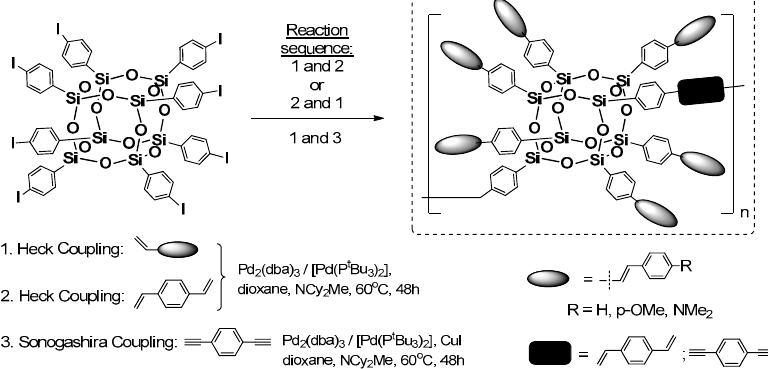
Figure 12. Synthetic approach for linear copolymers obtained via consecutive Heck and Sonogashira